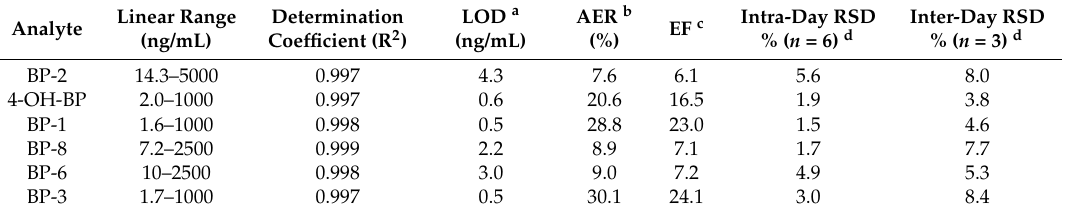
Table 2. The analytical parameters of the proposed method for the selected benzophenones (BPs). Linear Range Analyte (ng/mL)